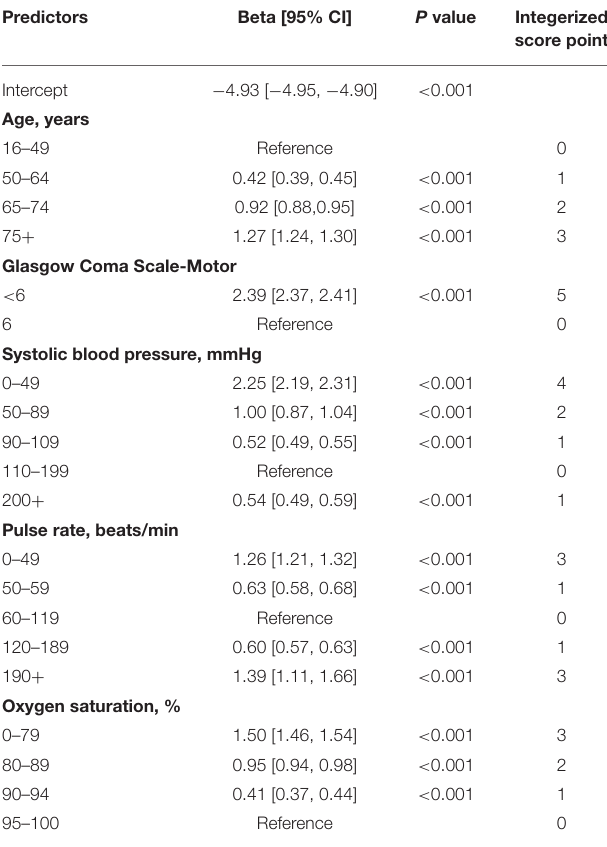
Supplementary Figure 2 . The SHAP plots of NN-CAPSO model are shown in Supplementary Figure 3